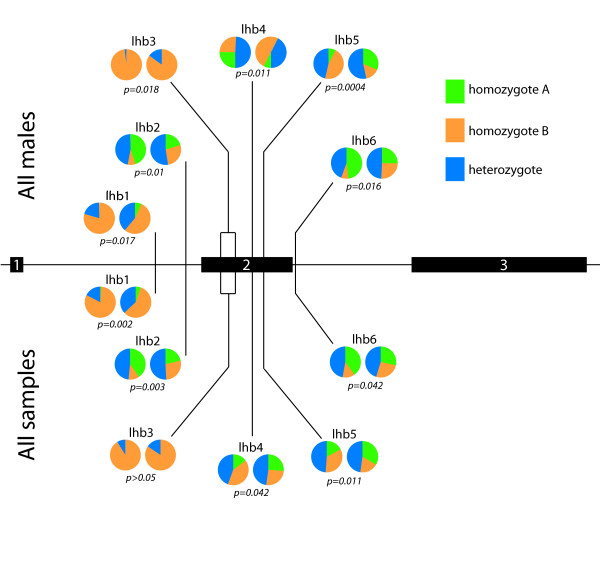
Significant linkage disequilibrium between lhcgr1 and multiple LHB loci. In the schematic of LHB, exons are represented as black boxes and the positions of the 7 LHB polymorphisms scored are indicated by vertical lines. lhb3 is composed of two SNPs, which are in complete LD with each other. For each polymorphism, genotype frequencies are represented in the form of two pie charts, where the left chart represents genotype frequencies among individuals lacking an LQ-insert allele in exon 1 of LHCGR (lhcgr1) and the right chart represents genotype frequencies among individuals possessing 1 or 2 LQ-insert alleles. Frequencies above the graphs correspond to AD males, while frequencies below the graph correspond to all individuals sampled in this study. * = significant difference (p < 0.05), ** = highly significant difference (p < 0.01).